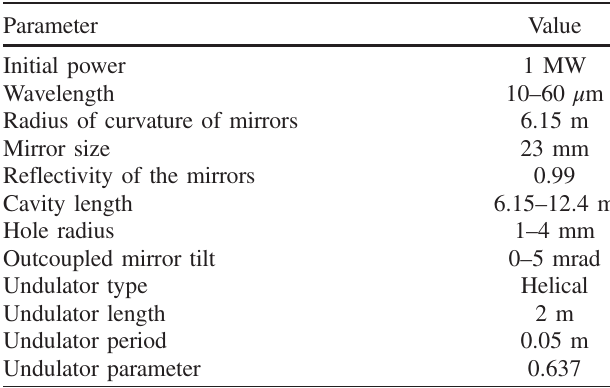
TABLE I. Parameters used in the simulations.